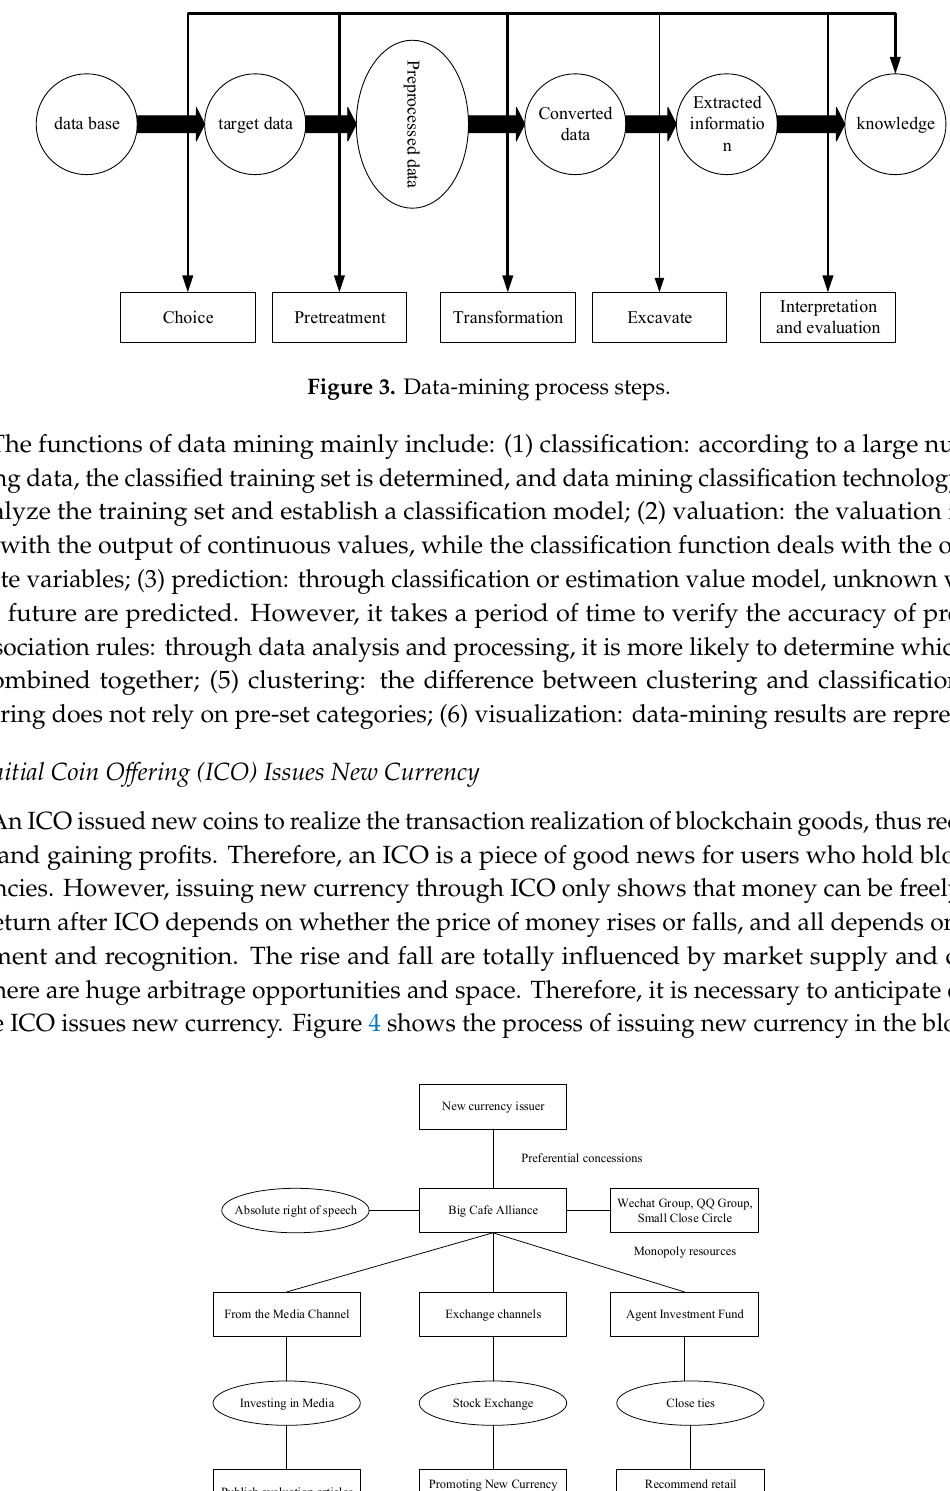
Figure 4. Flow chart of issuance of new initial coin offering (ICO) in blockchain.